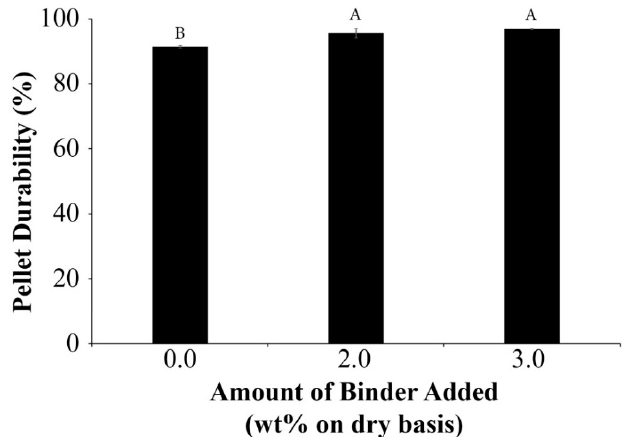
Figure 4. Effect of binder level on durability of torrefied wood pellets produced using a bench scale pelletizer. The peptides-PAE binder was generated using 22% PAE resin and 78% SRM peptides on a